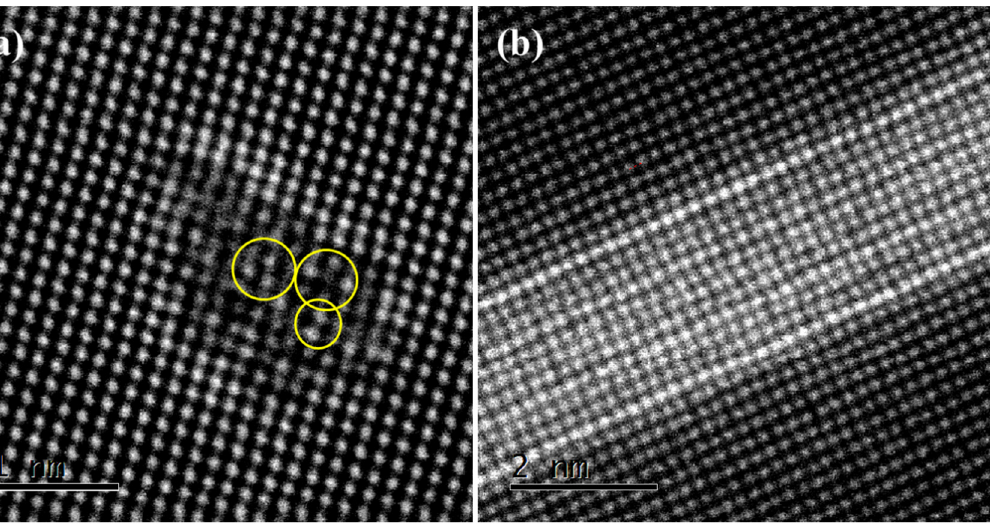
Figure 7. HAADF-STEM image of the GP zone in the alloy aged for 6 h, [100] (cid:3002)(cid:3039) ( a ) type I GP zone; ( b ) type II GP zone. ( b ) type II GP